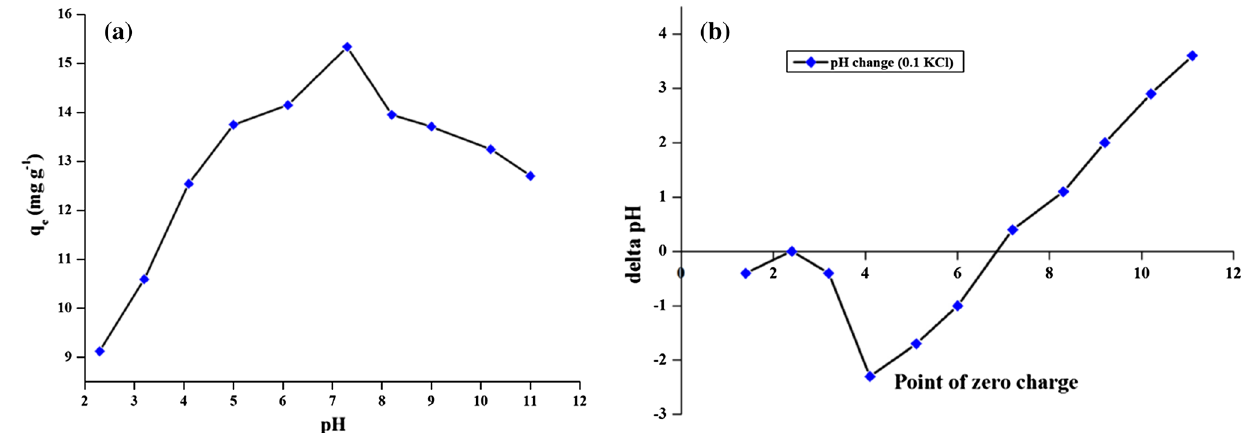
Fig. 7 a Effect of pH and adsorption of CV onto PGADP b Point of zero charge (conditions; adsorbent dose = 0.025 g; CV = 20 mgL −1 ; tem- perature = 30 °C)